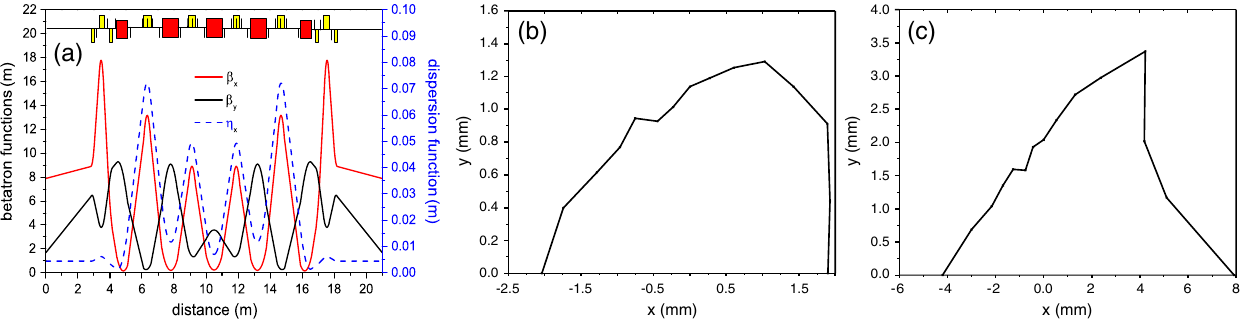
FIG. 7. Lattice C. The betatron function and dispersion function [plot (a)], the dynamic aperture obtained by the MAD HARMON command [plot (b)], and the dynamic aperture obtained by NSGA-II [plot (c)]. The emittance value is 60.7 pm rad. The tunes in the horizontal and vertical planes are (cid:6) x ¼ 45 : 877 366 and (cid:6) y ¼ 31 : 031 640 . The natural chromaticities of both planes are (cid:5) ¼ (cid:1) 152 : 995 732 and (cid:5) ¼ (cid:1) 65 : 451 753 , respectively. The corrected chromaticities are (cid:5) x y